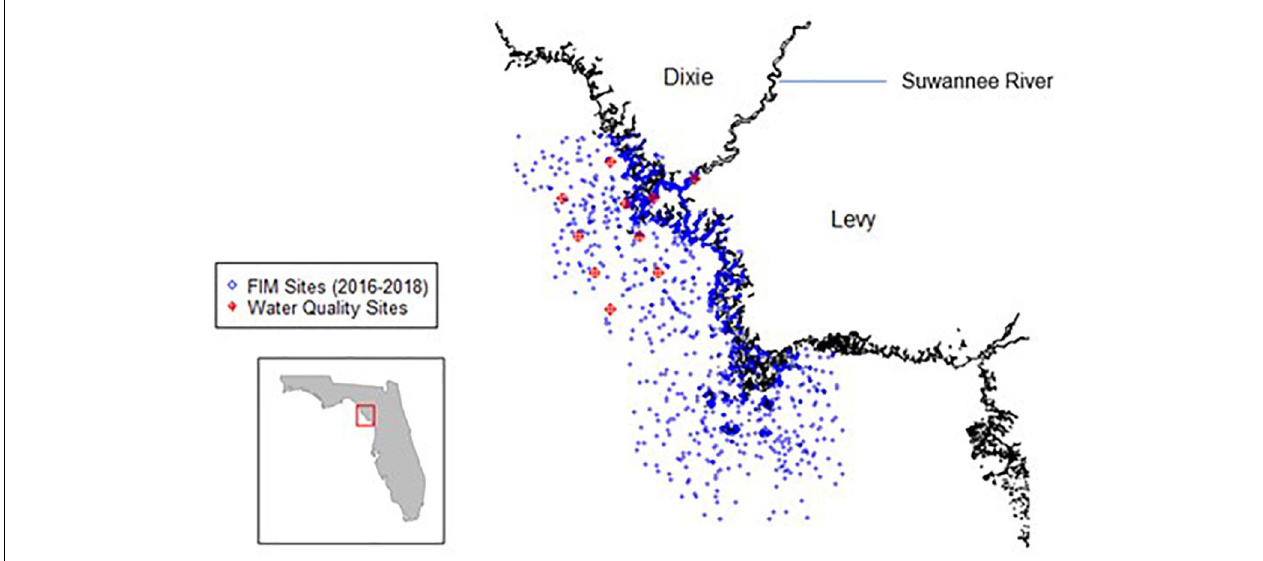
FIGURE 1 | Map of the Suwannee River Estuary. FIM sampling locations from 2016 to 2018 are in blue, and Project COAST water quality sites are in red (Florida Fish and Wildlife Conservation Commission, 2021; Frazer,